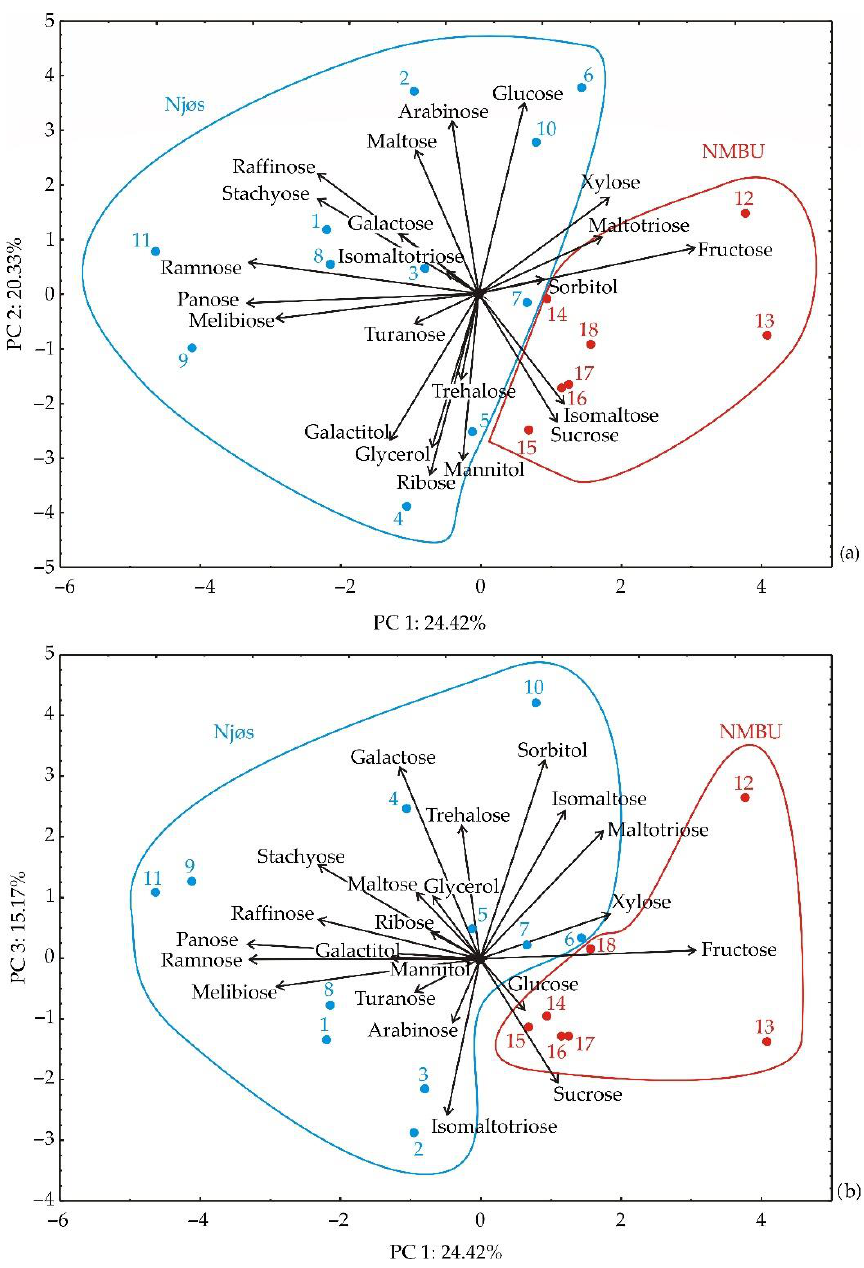
Figure 4. PCA ordination of sugar content variables: ( a ) projection in PC1-PC2 plane; ( b ) projection in PC1-PC3 plane.